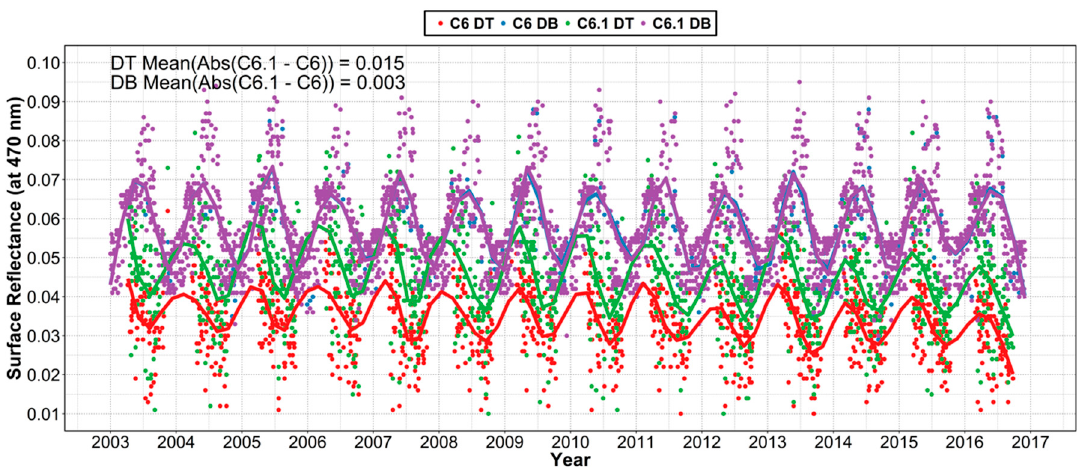
Figure 11. Time series of surface reflectance at 470 nm from the MODIS-Terra C6/C6.1 DT and DB products at Beijing site from January 2003 to December 2016.